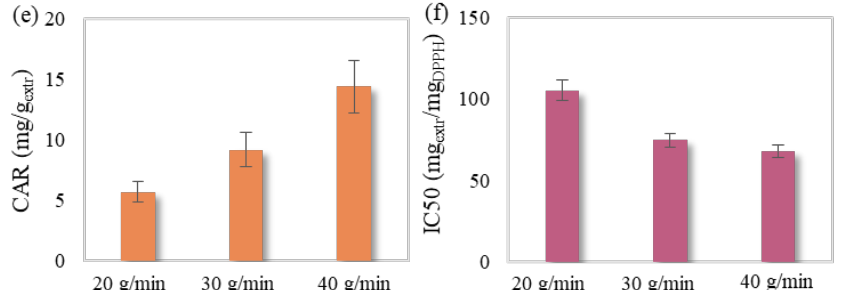
Figure 3. Flow rate effect on SFE’s ( a ) yield, ( b ) total phenolic, ( c ) chlorophyll, ( d ) selected carotenoid, ( e ) total carotenoid content and ( f ) antioxidant activity examined at a temperature of 50 ◦ C and a pressure of 180 bar. The presented error bars express the standard deviation percentage of the central point replicates.